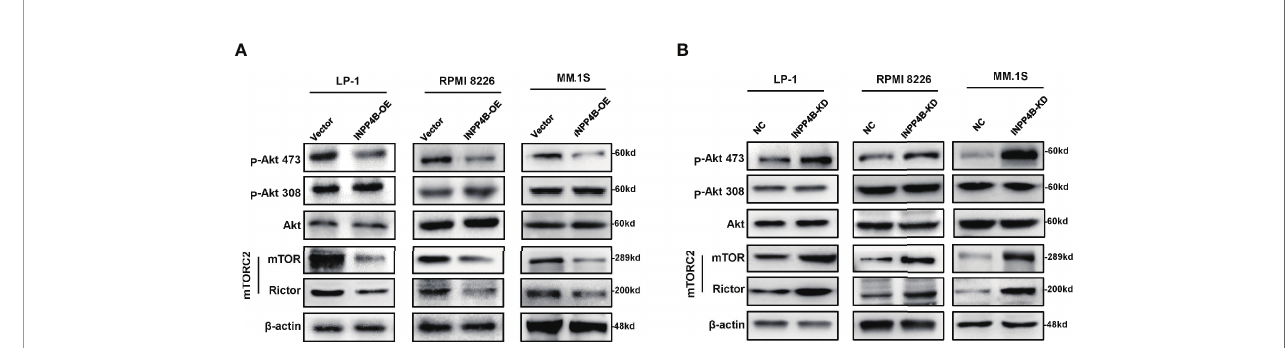
FIGURE 4 | INPP4B inhibits MM cells growth via regulating the PI3K/Akt pathway. (A) Western blot analyzes the relative protein levels of Akt, p-Akt (thr308), p-Akt (ser473), rictor-mTOR complex (mTORC2) in LP-1, RPMI 8226, and MM.1S cells after lentiviral-carrying INPP4B overexpression for 48 h and (B) detections in LP-1, RPMI 8226, and MM.1S cells after lentiviral-carrying INPP4B knockdown for 48 h.